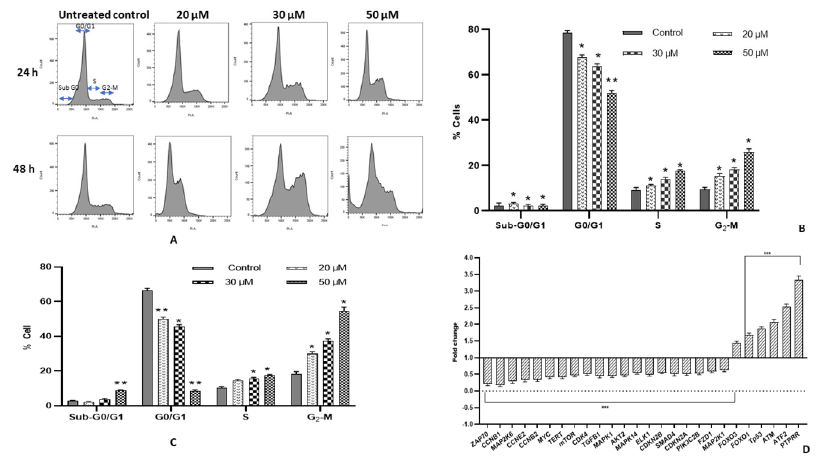
Figure 2. ( A ) Flow cytometry analysis: Analysis of DNA content of treated HeLa cells with 20, 30 and 50 µM of fisetin for 24 and 48 h was compared with DMSO control cells, after PI staining. It demonstrated G2/M arrest cell cycle arrest with increase in sub-G0 apoptotic population. ( B , C ) Graph represents % distribution of cells across the different phases of cell cycle in 24 and 48 h, respectively. ( D ) RQ plot of HeLa cells followed by treatment with fisetin for 48 h resulted in down- regulation of various cell cycle regulators, genes involved in PI3K/AKT, MAPK and WNT signalling, while upregulation in TSGs expression compared with the control. The data are expressed as the mean ± standard deviation of three independent experiments. Statistically significant differences are marked by asterisks: two-way ANOVA * represents p < 0.05; ** represents p < 0.01. Fisetin-mediated G2/M cell cycle arrest was additionally substantiated by evaluating modulation in genes manifestation involved in cell cycle regulation, after treatment at 50 µ M only. Fisetin illustrated downregulation of CCNB1, CCNB2, CCNE2, CDK2 and, CDK4 corresponding to G2/M phase arrest and TERT enzyme, which deters cell proliferation. In contrast, PTPRR, FOXO1, FOXO3 expression was elevated. PTPRR acts as an ERK/MAPK pathway inhibitor, while the latter two play a significant role in the extrinsic apoptotic pathway by upregulating FasL and TRAIL (pro-apoptotic factors) (Table 1) (Figure 2D). Table 1. Table showing expression of various genes and proteins being modulated by fisetin to carry out its anticancer